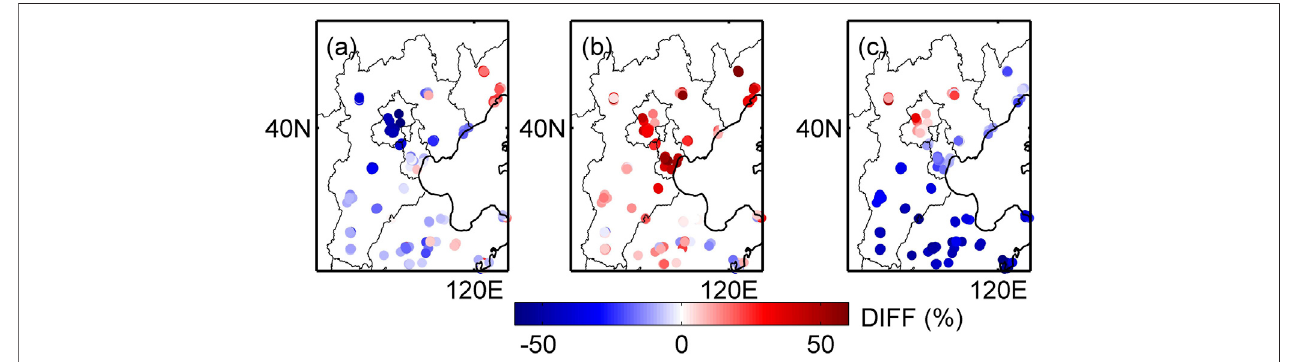
FIGURE 2 | The anomaly of PM 2.5 in 2020 relative to the same period in 2015 – 2019 for 1 – 20 January (A) , 21 January to 9 February (B) , and 10 – 29 February (C) .